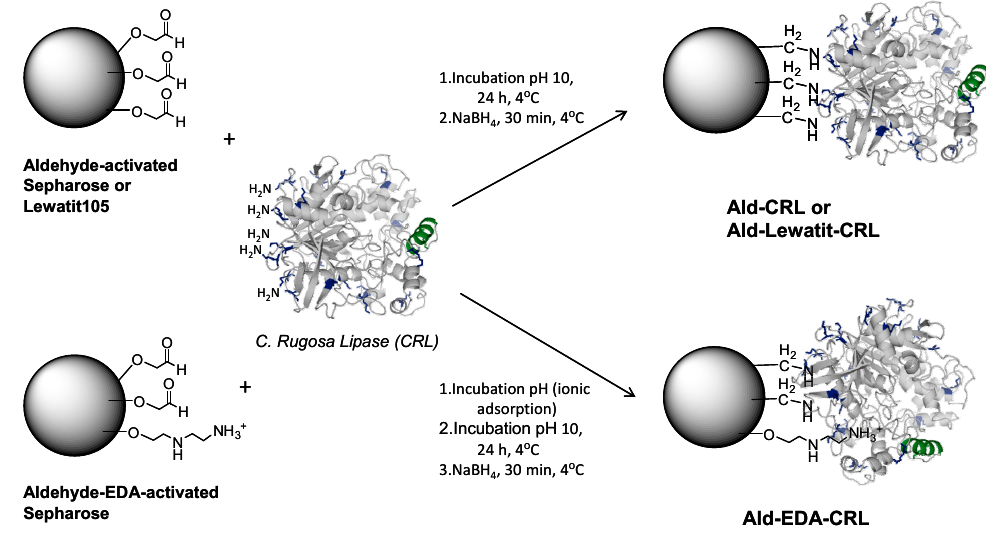
Scheme 1. Covalent immobilization of CRL by different